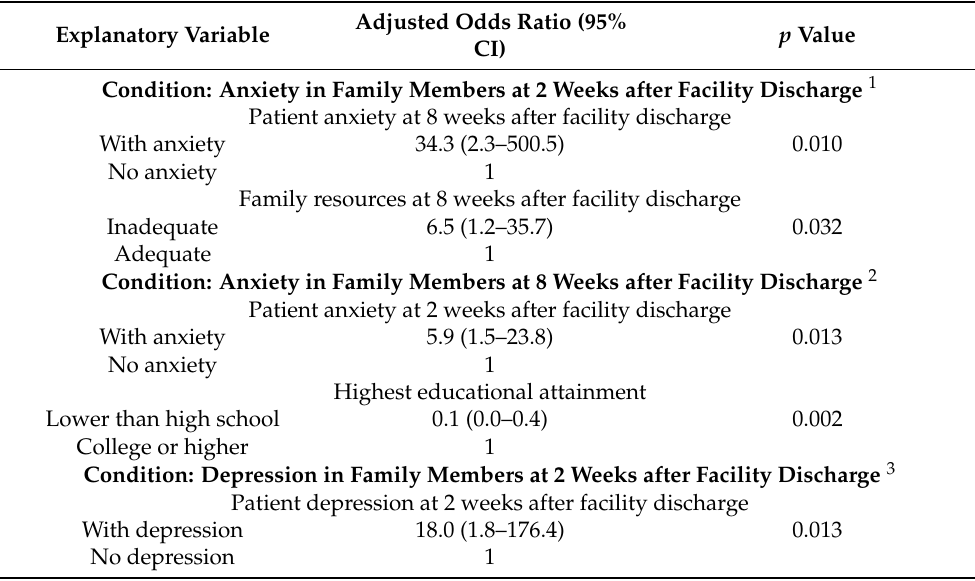
Table 8. Factors associated with psychological symptoms in patients’ family members identified by multivariate logistic regression